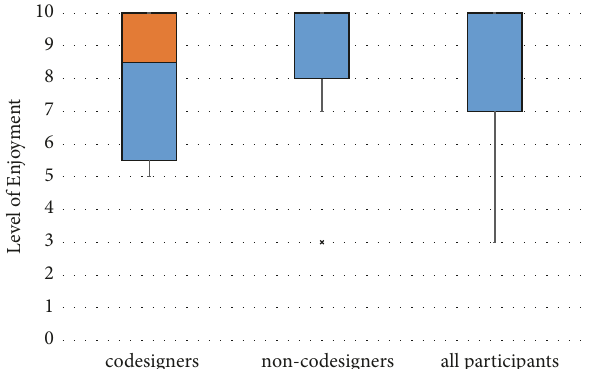
Figure 18: Answers from topic 19 of Table 9: this topic measures the enjoyment proportioning the game.